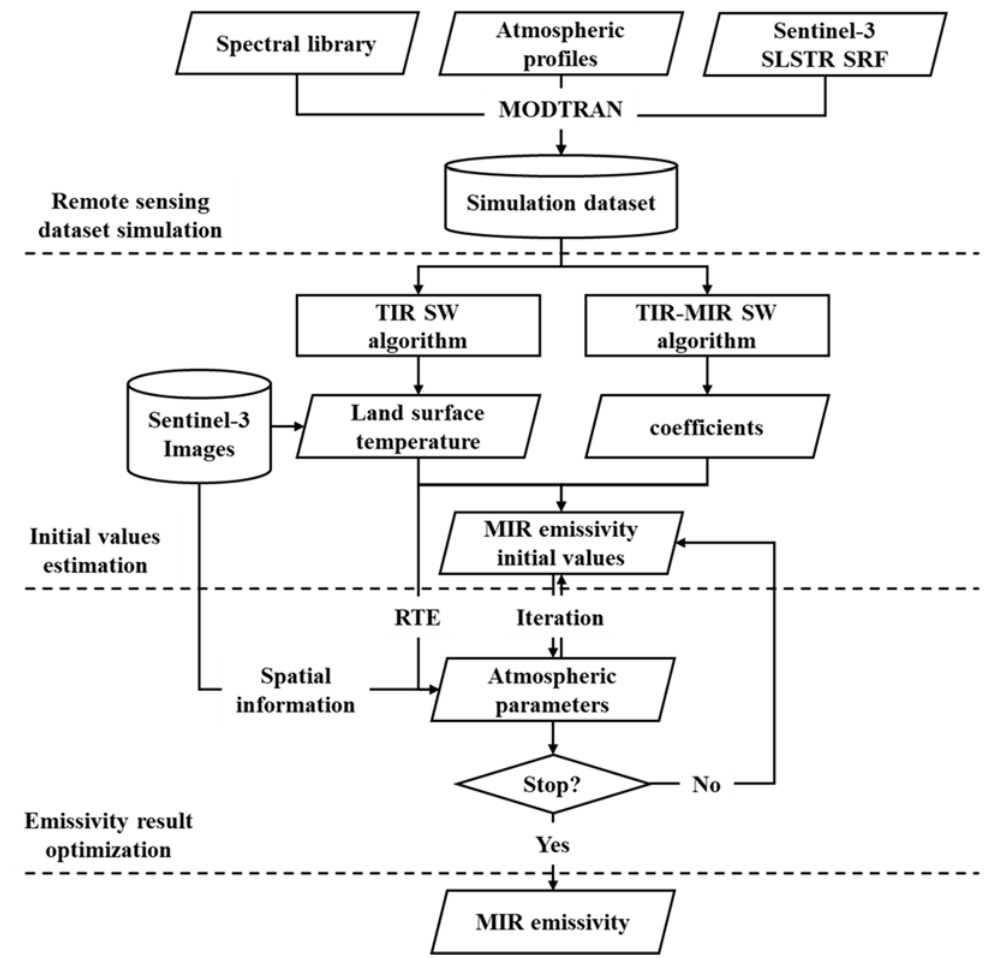
Figure 1. Flowchart of the proposed MIR emissivity retrieval method.